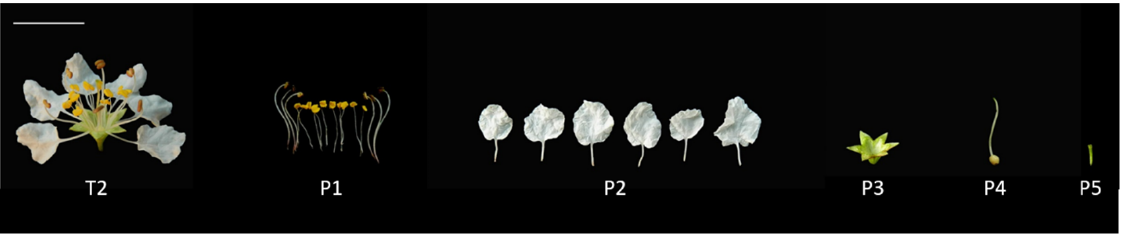
Figure 9. Three main flowering stages of the L. caudata flower. T1, pre-blooming stage; T2, full- blooming stage; T3, over-blooming stage; bar, 1 cm.